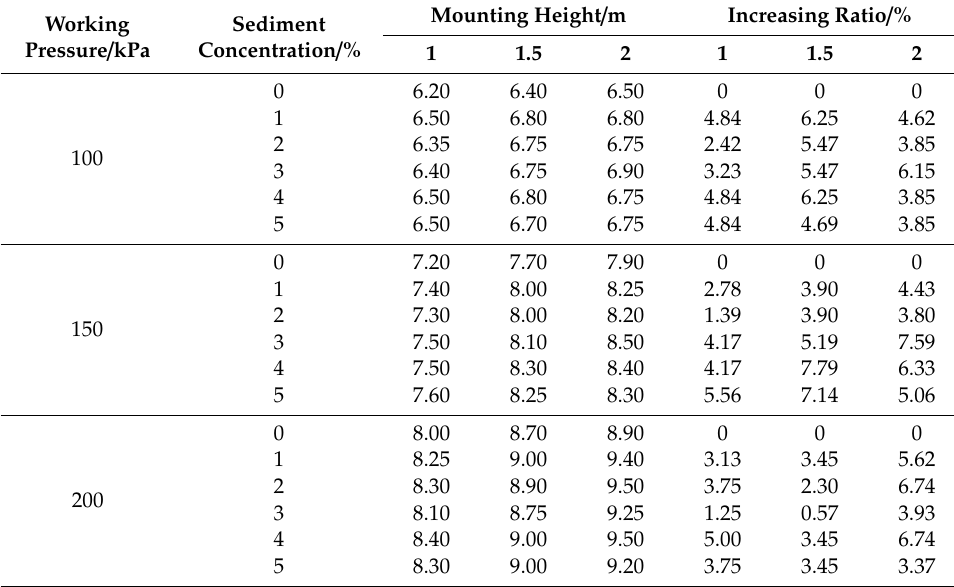
changeinspray distance. Table 2. Spray distance (m) with di ff erent